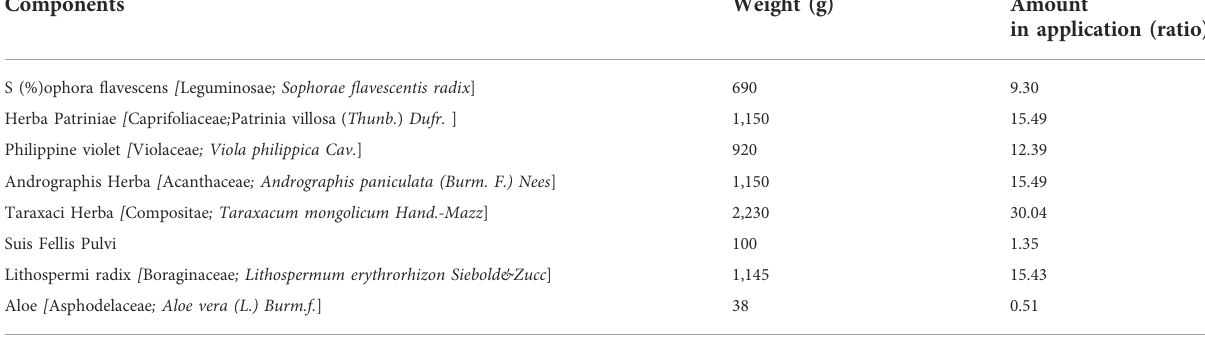
TABLE 1 The ratio of the components present in the preparation of Kangfuxiaoyanshuan (KFXYS).